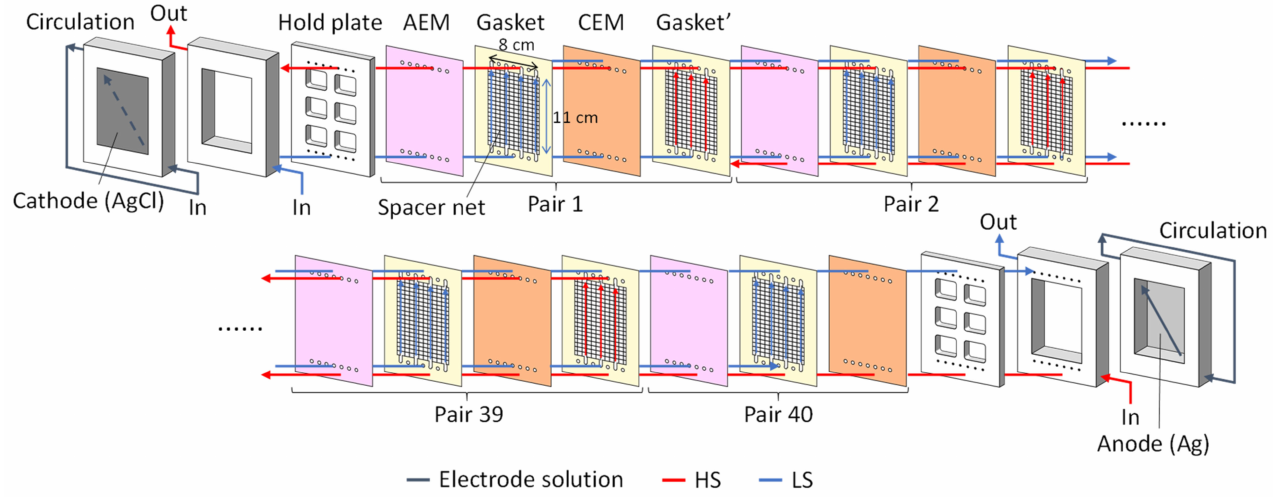
Figure 1. Schematic illustration of the lab-scale RED